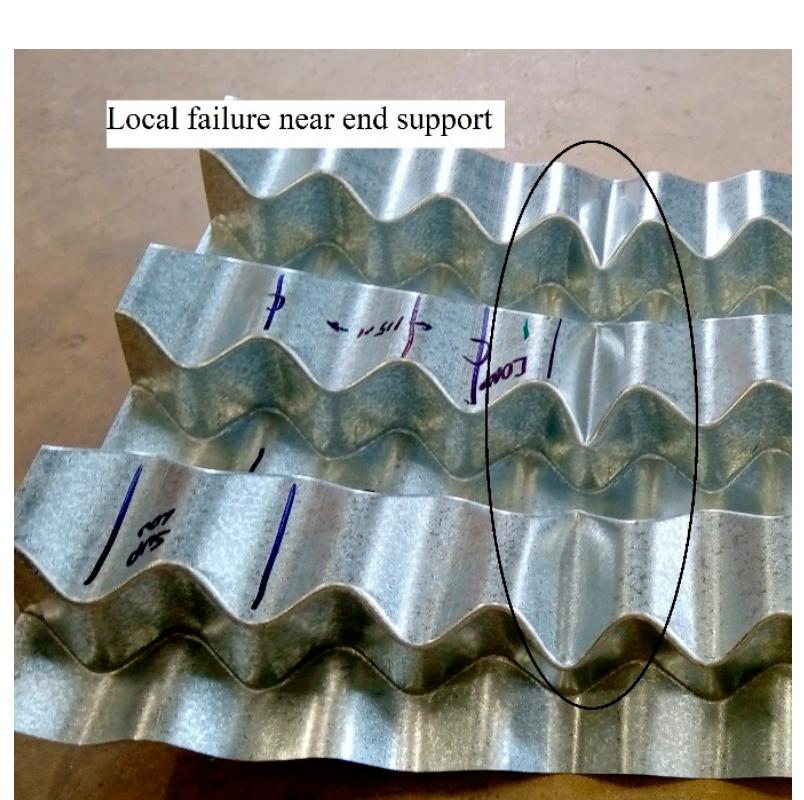
Figure 17. Local failure near the support.